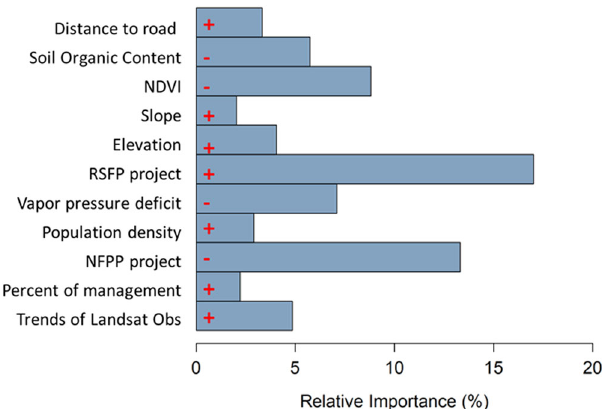
Fig. 4 Relative importance of variables on the trends of annual disturbed forests based on the generalized linear model. The + ( − ) indicated the variable had positive (negative) effects on the trends of annual disturbed forests. Abbreviations are: NDVI Normalized difference vegetation index, RSFP Yangtze River and Zhujiang River Shelter Forest Projects, and NFPP Natural Forest Protection